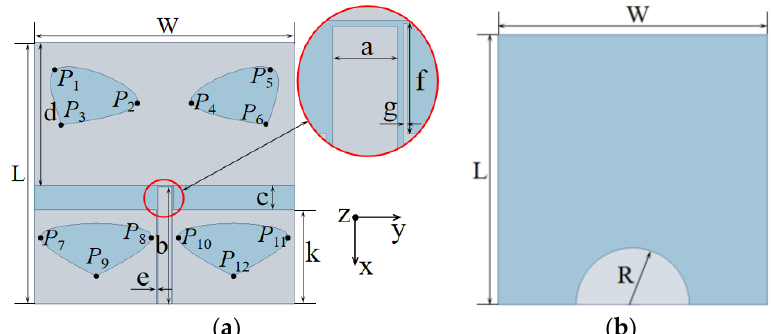
Figure 3. Geometric configuration of the proposed antenna: ( a ) top side and ( b ) bottom side, where L = W = 38 mm; H = 1 mm; R = 9.1 mm; a = 2 mm; b = 17.1 mm; c = 3.5 mm; d = 20.7 mm; e = 0.1 mm; f =